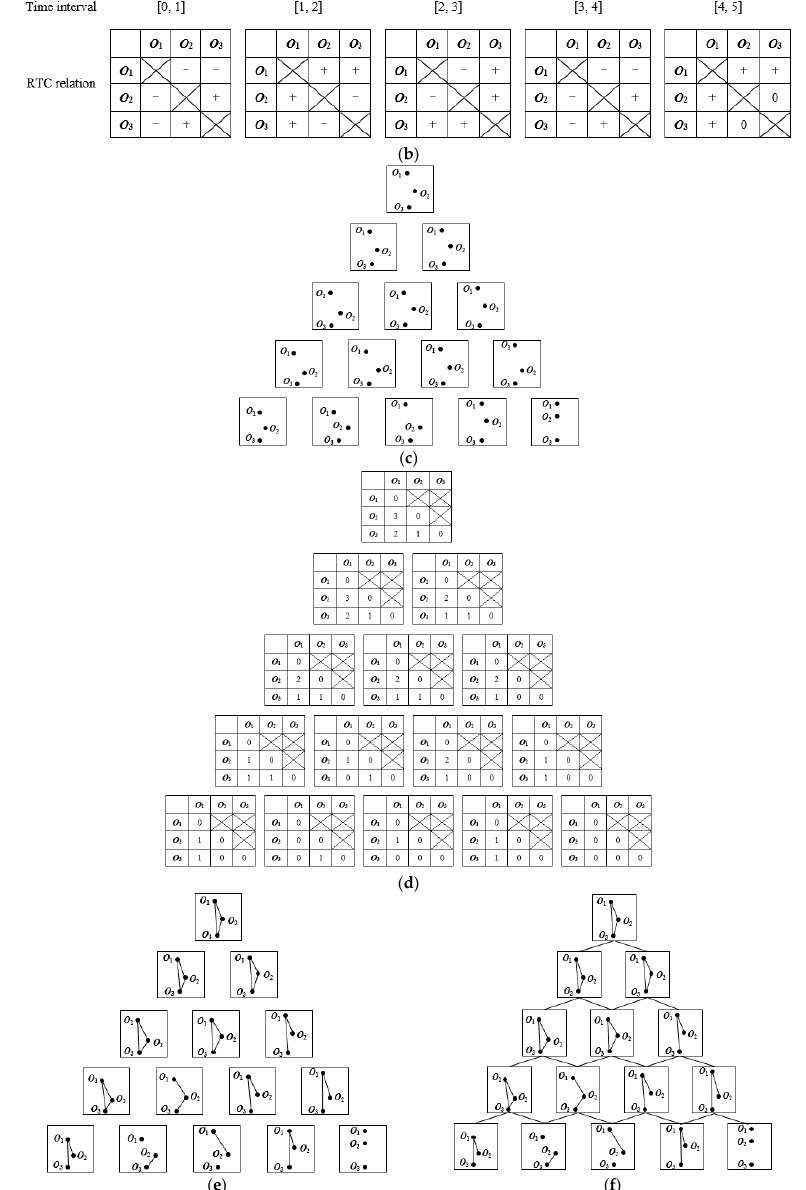
Figure 4. Illustration of the generation of a MTSSTN: ( a ) the three sample trajectories during five consecutive time intervals at the finest temporal scale; ( b ) the RTC relations during each time interval at the finest temporal scale; ( c ) the generated vertices of the sub-networks; ( d ) the adjacency matrix generated based on the attraction pattern during the time intervals at multiple temporal scales; ( e ) the generated edges of sub-networks, and ( f ) the generated MTSSTN.